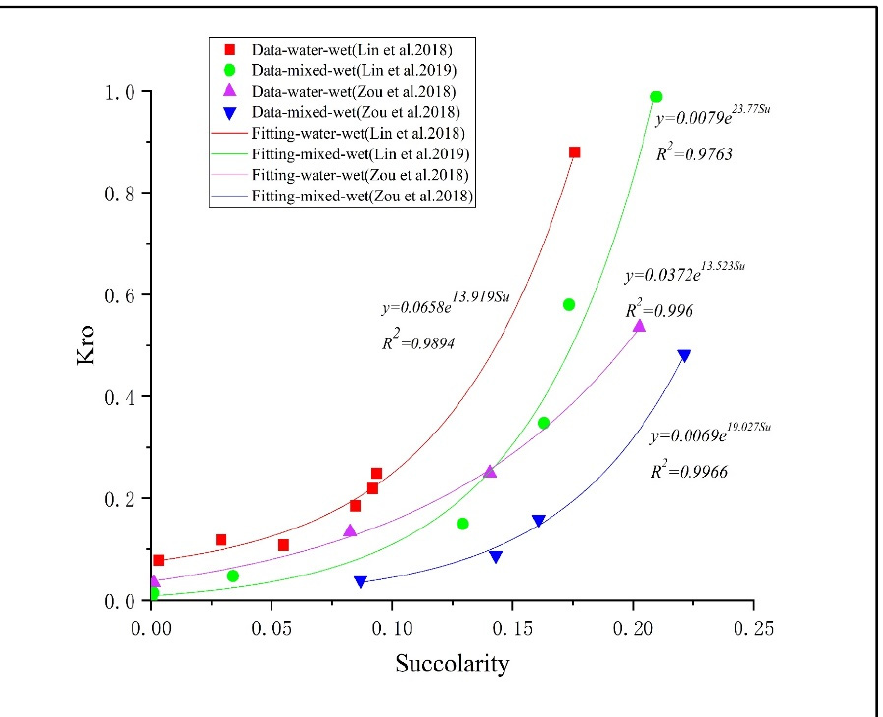
Figure 7. K ro versus succolarity of the works and the fitting exponential model. Table 2. Parameters for the exponential model fit y = a e bs u listed in Table 1. Work